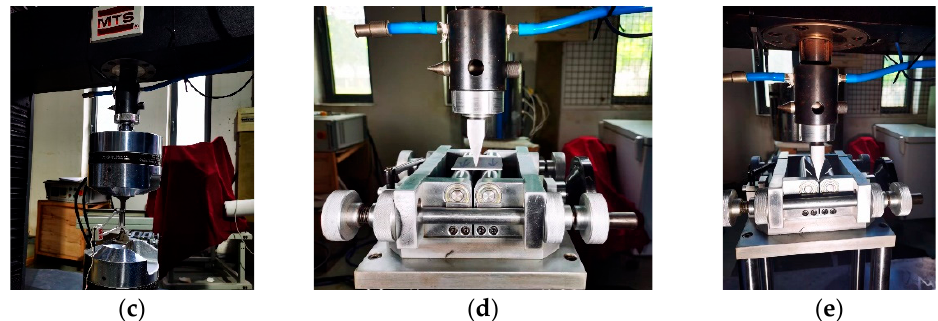
Figure 1. ( a ) Geometries of tensile specimens; ( b ) geometries of three-point bending specimens; ( c ) tensile testing machine with a 50 mm extensometer; ( d ) three-point bending device; ( e ) picture taken during the three-point bending process.